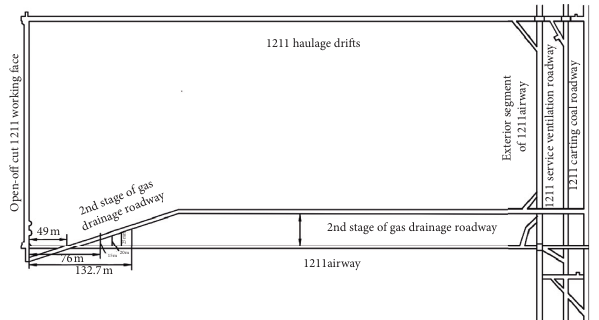
Figure 8: GDR layout in #1207 working face.